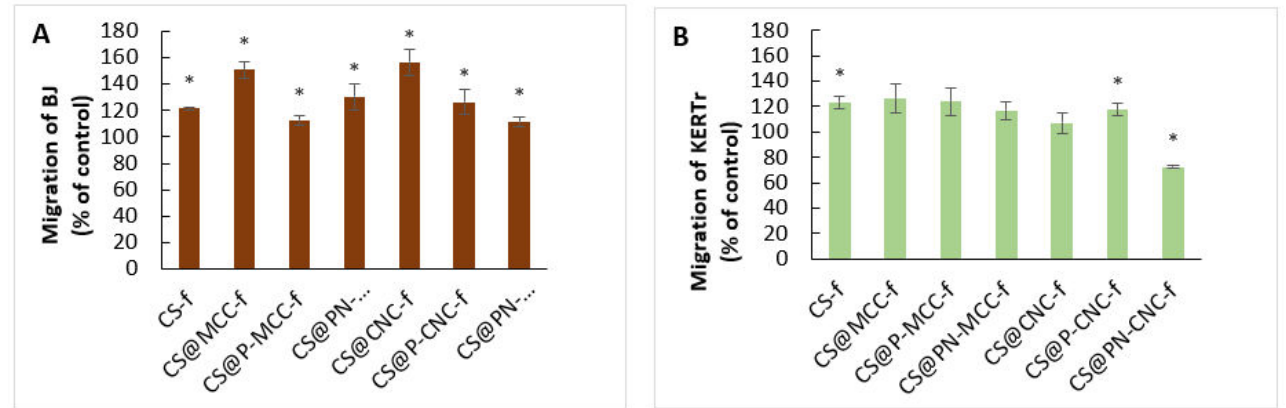
Figure 7. The migration of BJ ( A ) and KERTr ( B ) cells incubated for 24 h with chitosan-cellulose biocomposites, n = 6, * p <